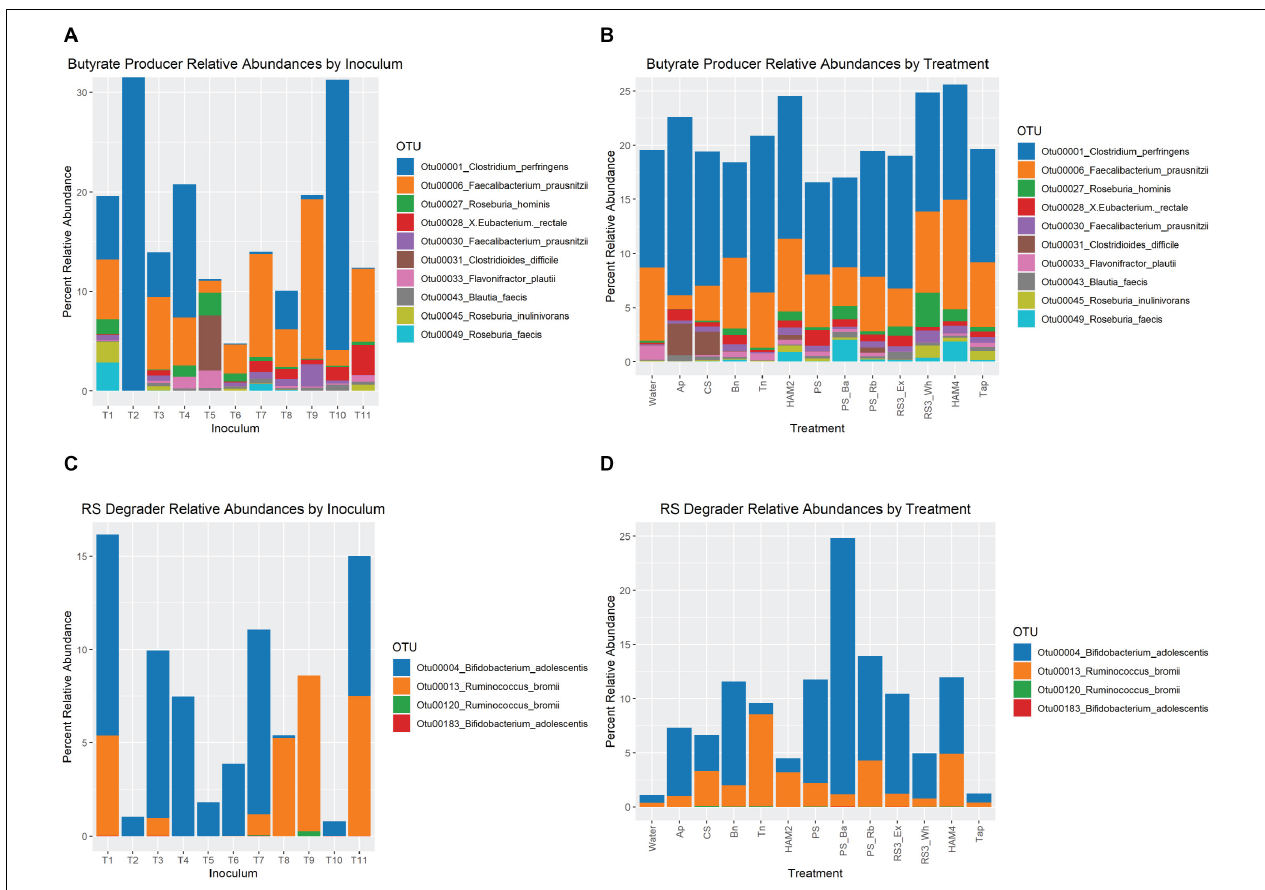
FIGURE 6 | Relative abundance of butyrate producing and resistant starch degrading organisms. (A) Relative abundance of OTUs associated with butyrate producing organisms at the end of fermentation, averaged for each starting inoculum across all treatments. (B) Relative abundance of OTUs associated with butyrate producing at the end of fermentation, averaged for each treatment across all inocula. For both (A,B) only the top 10 most abundant butyrate-producer OTUs are included. (C) Relative abundance of OTUs associated with resistant starch degrading organisms at the end of fermentation, averaged for each starting inoculum across all treatments. (D) Relative abundance of OTUs associated with resistant starch degrading organisms at the end of fermentation, averaged for each treatment across all inocula. Ap, amylopectin; CS, corn starch; Bn, green banana flour; Tn, tiger nut flour; HAM2, high amylose maize starch; PS, potato starch; PS_Ba, potato starch with fecal samples supplemented with Bifidobacterium adolescentis ; PS_Rb, potato starch with fecal samples supplemented with Ruminococcus bromii ; RS3_Ex, retrograded extracted potato starch; RS3_Wh, retrograded whole potatoes; HAM4, chemically cross-linked high amylose maize starch; Tap, chemically cross-linked tapioca